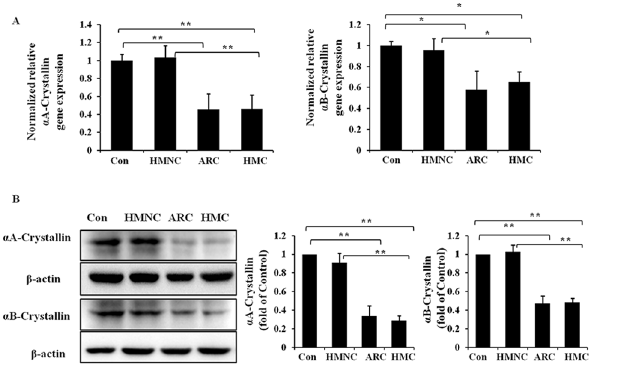
Fig 1. Relative α A- and α B-crystallin mRNA and soluble protein expression in the lens epithelium of HMC. RNA and soluble protein were extracted from human epithelium specimens of HMC, HMNC, ARC or normal control (Con) samples. Real-time PCR was performed to detect the mRNA levels of α A- and α B- crystallin (Fig 1A) in each group, and 18S was used as the internal control gene. Western blot assays